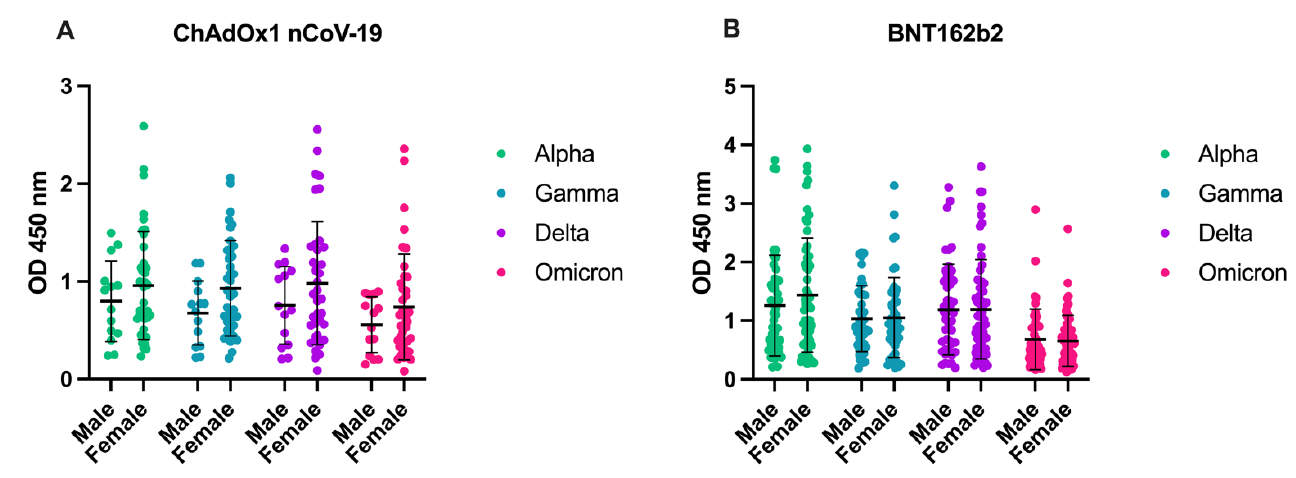
Figure 5. Gender dependence of RBD variant–specific IgG induction following vaccination with ei-